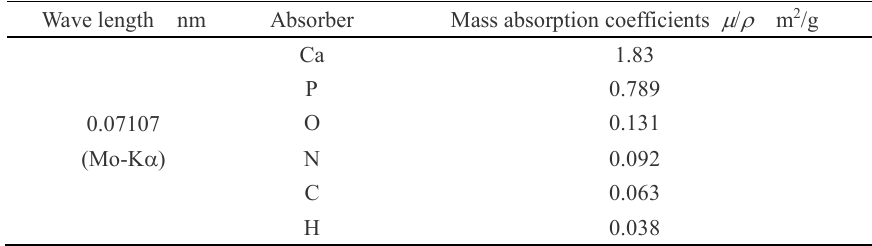
Table 1 Mass absorption coefficient of the elements for characteristic X-ray Mo-K α